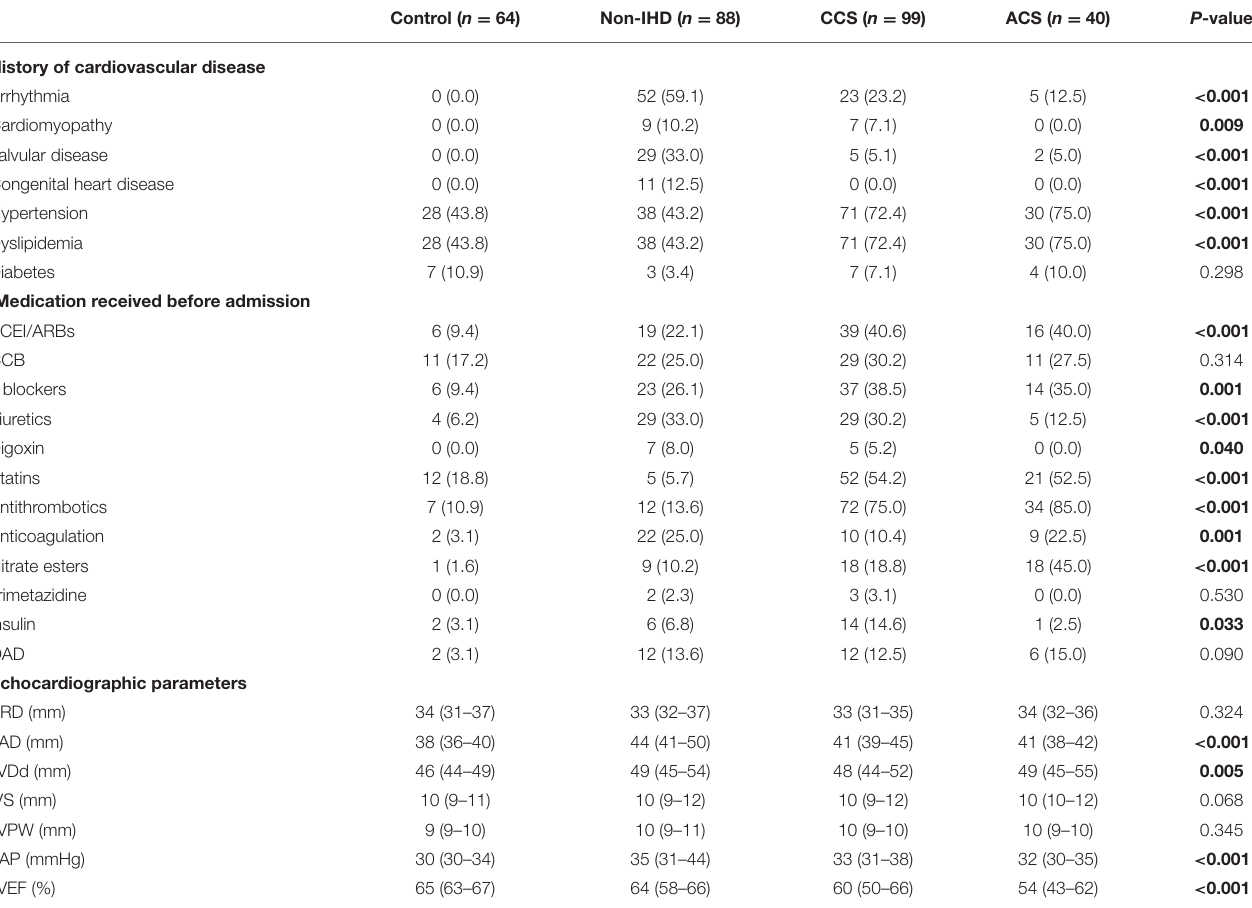
TABLE 2 | Medical history and echocardiography of the study